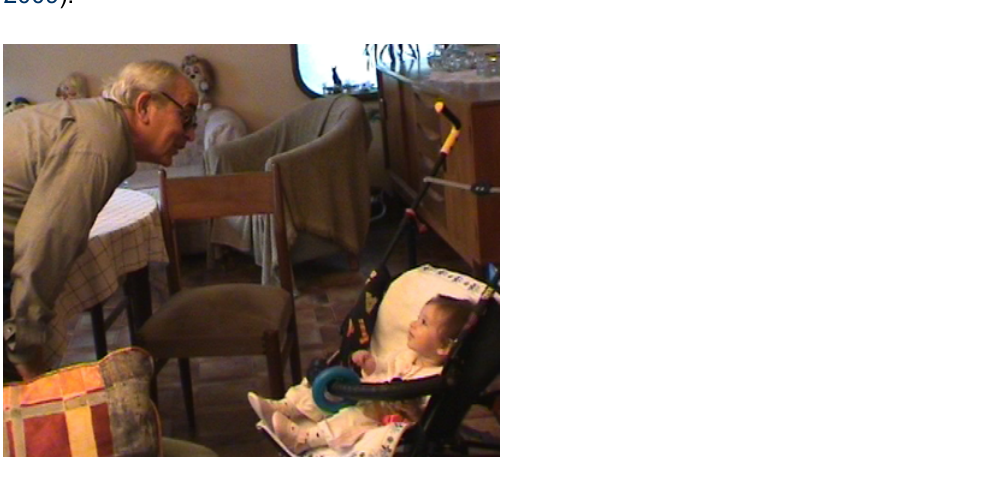
Figure 1.1. Hand movement imitative episode in grandfather-infant grandchild (girl-7.5 months old) interaction: In the course of eye contact, the grandfather is looking at his infant grandchild with a pleasure-interest expression (smile with raised eye brows) while he is leaning towards her and the infant is grinning to him.